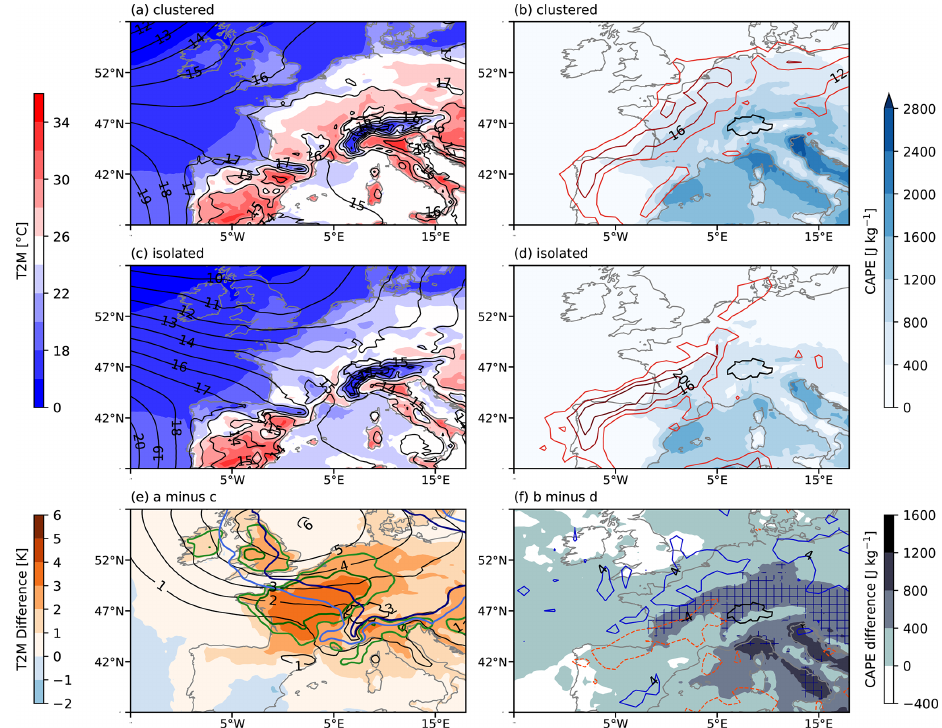
Figure 6. Weather patterns during clustered and isolated hail days north of the Alps. (a) Daily maximum T2M (color shading; in ◦ C) and daily mean sea level pressure (black contour lines, labels indicate by how much the MSLP exceeds 1000hPa in hPa) on clustered hail days; (b) MUCAPE (color shading, Jkg − 1 ) and front frequencies (red, labeled lines) on clustered hail days; (c, d) same as panels (a) and (b) but for isolated hail days. (e) Difference of panel (a) minus panel (c) of T2M (color shading) and MSLP (black contour lines). Statistically significant differences for more than 50% of the resample composites (lighter contour lines) and more than 80% (darker contour lines) are shown in green for T2M and in blue for MSLP and smoothed as in Fig. 5. (f) Difference of panel (b) minus panel (d) for MUCAPE (color shading) and front frequency (blue and red contour lines); the areas with > 50% significant differences in MUCAPE are shown in blue hashes ( > 80% almost never